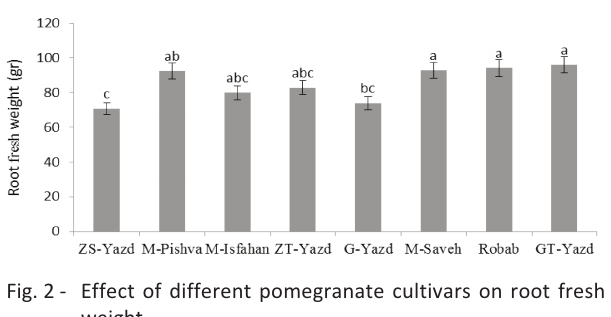
Fig. 2 ­ Effect of different pomegranate cultivars on root fresh weight.